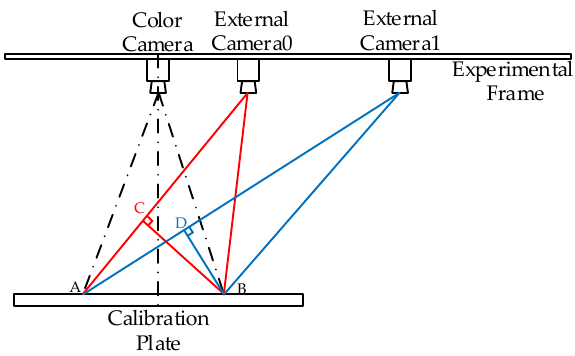
Figure 5. The top view of the experimental framework. Table 1. External camera correspondence coefficient.